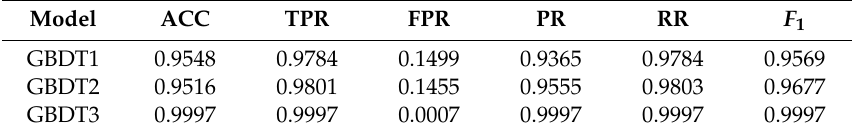
Table 8. Performance comparison of three models of 100 k WIDE TCP flow datasets.